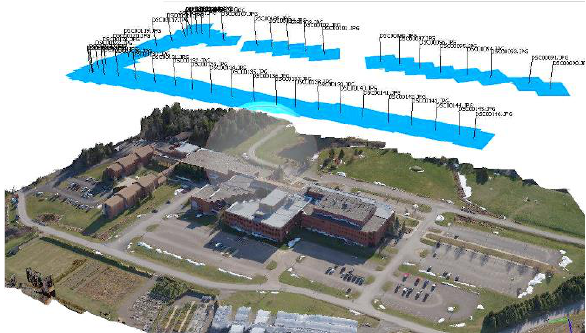
Figure 1. Sample project: flight planning over office